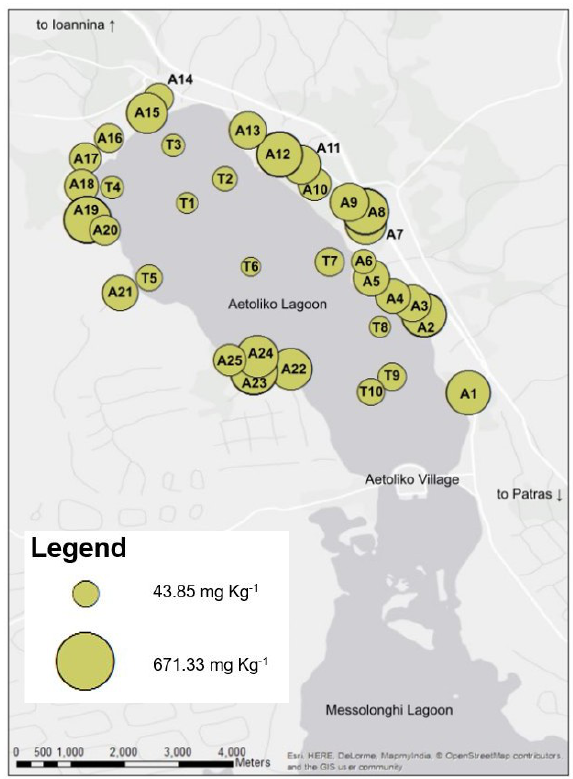
Figure 3. Total copper content of all samples.